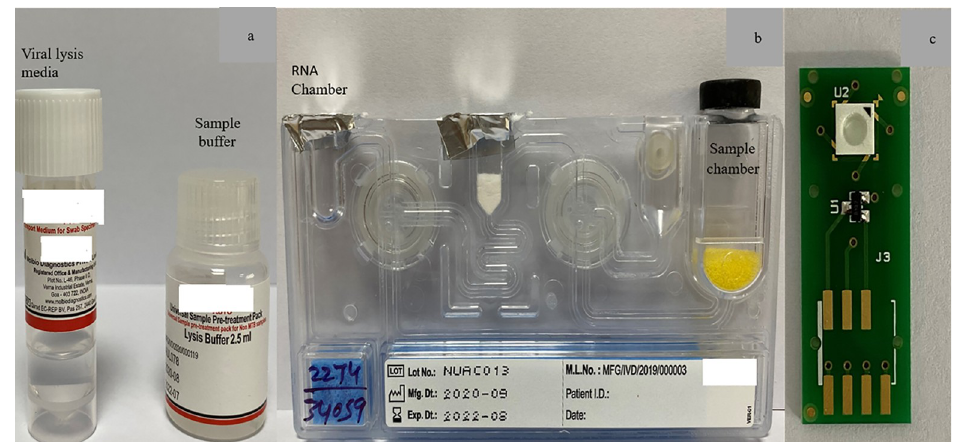
Fig 1. Heading: Images of consumables used in the TrueNat assay. Legend: (1a) Viral Lysis media and the sample buffer. (1b) RNA extraction cartridge. (1c) Micro PCR chip.